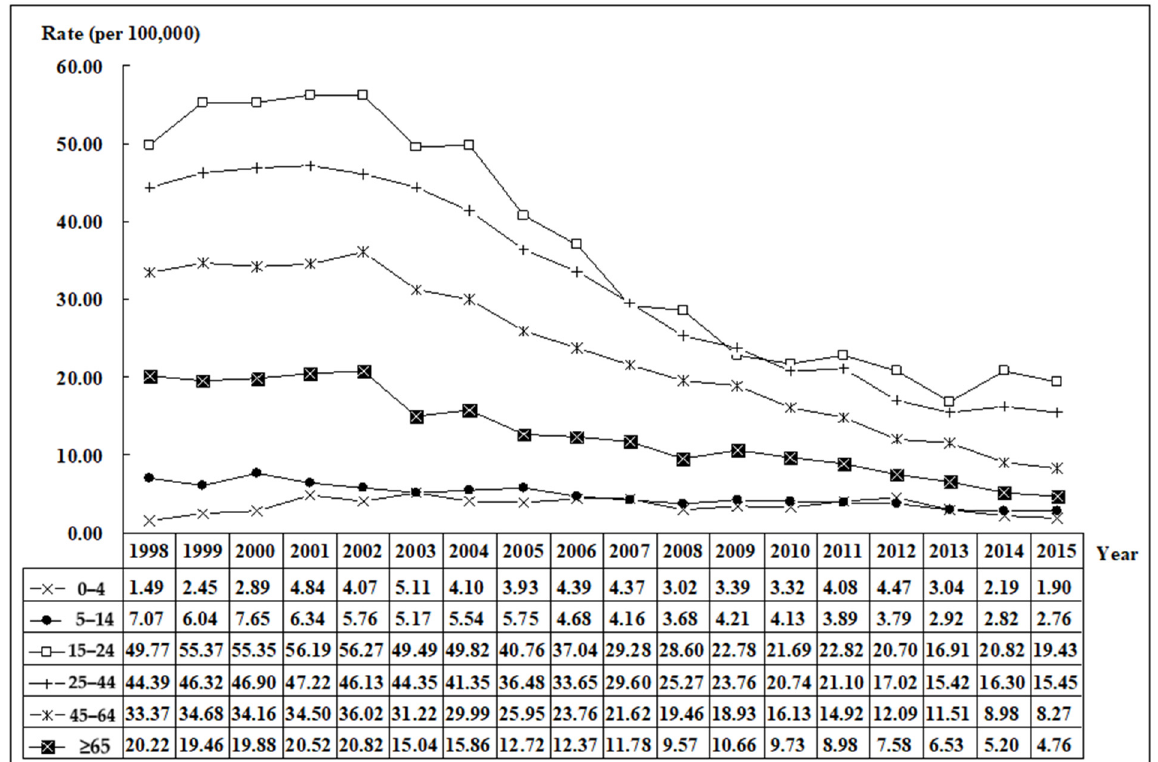
Figure 2. The trend of homicide hospitalization rates by age groups in Taiwan, 1998–2015.